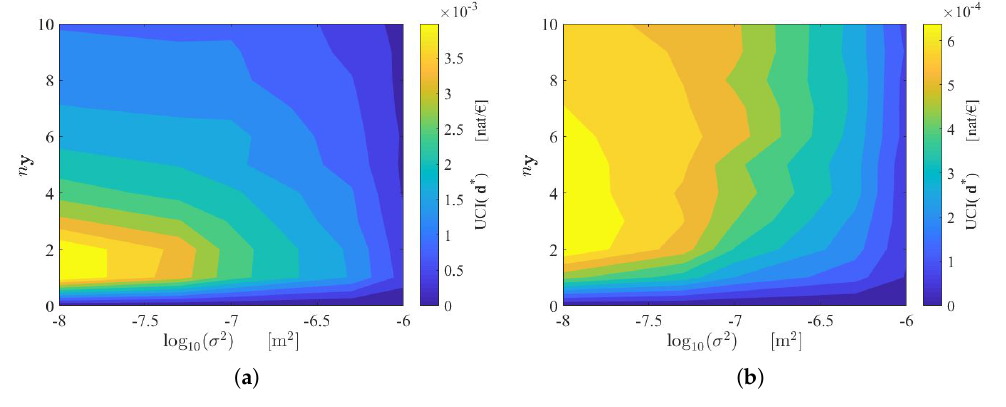
( d ∗ , n y , σ ) , with ( a ) C 0 = 500 e and ( b ) C 0 = 1000 e C ( n y , σ )